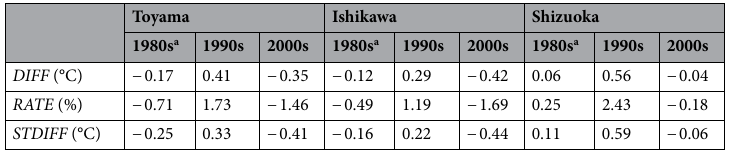
which does not migrate to high mountainous areas, decreased as sharply as S. frequens in Toyama 27 (Fig. 1g). Association between temperature and dragonflies. ∆ TEMP t was negatively correlated with the pop- ulation growth of S. frequens (λ t ) in the same year (Fig. 2a: Model 1, β = − 0.232, P = 0.029, R 2 = 0.429, Akaike’s